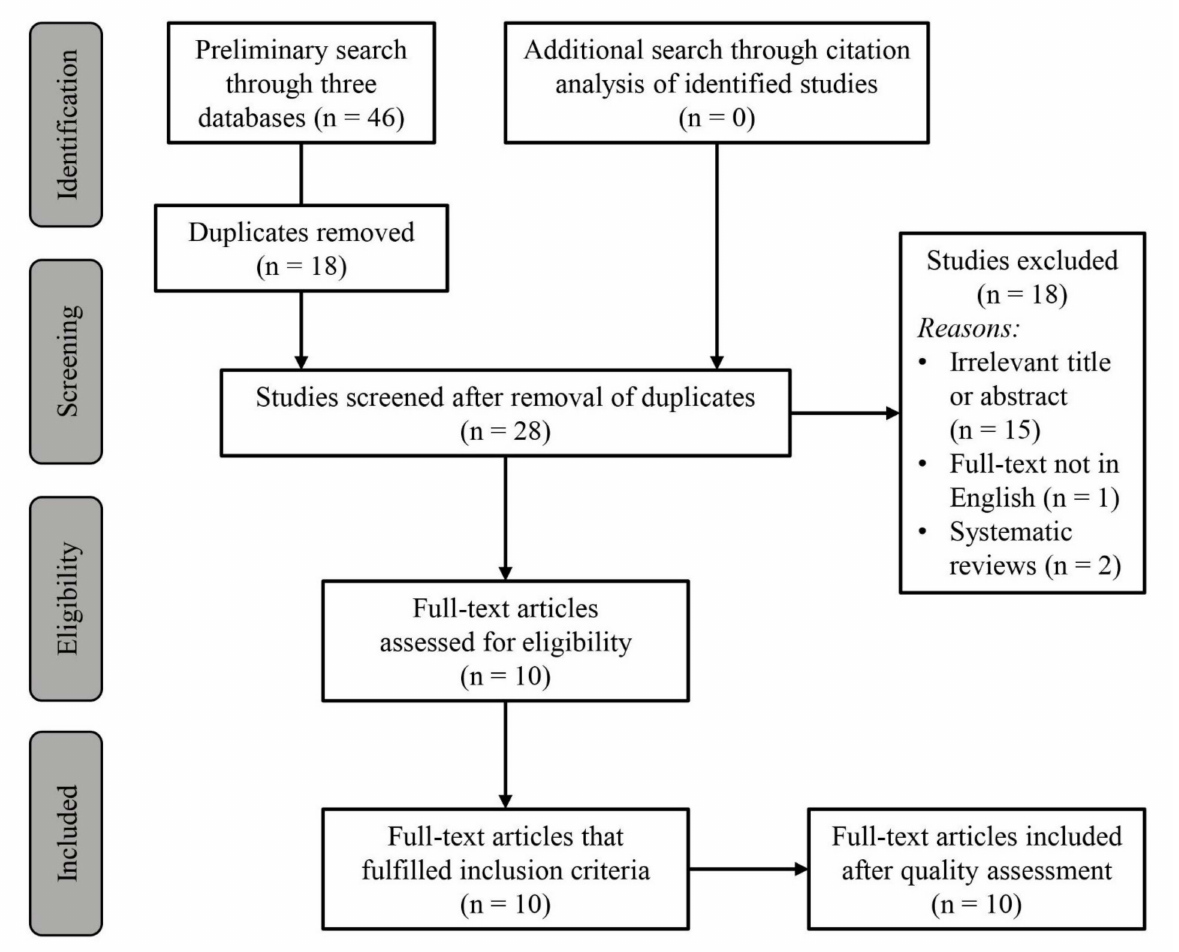
Figure 1. Search strategy and study selection process using PRISMA